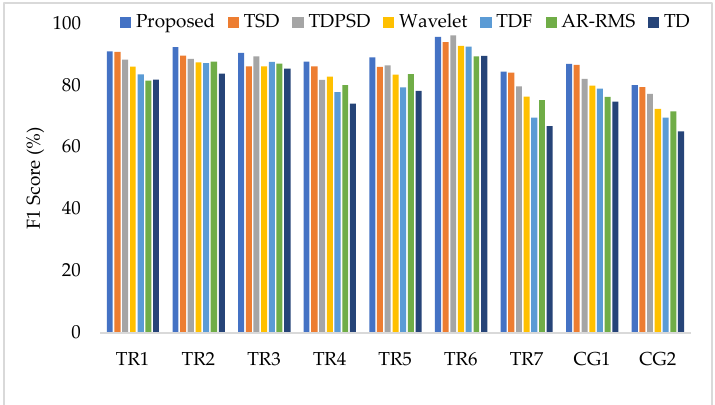
Figure 10. The amputee-wise performance when the SVM is trained and tested with three forces.